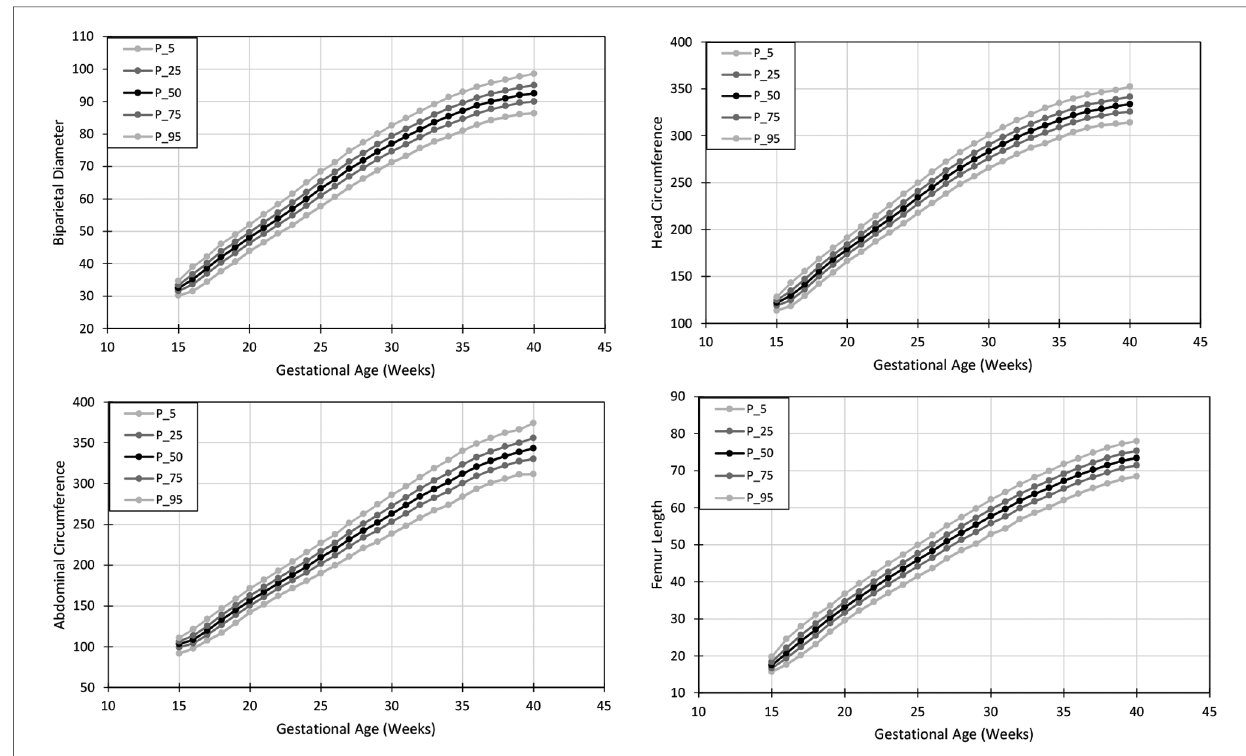
FIGURE 2 Local fetal growth reference charts for biparietal diameter, head circumference, abdominal circumference, and femur length using LMS method.